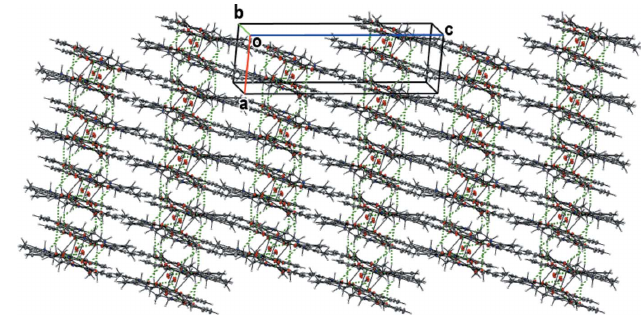
Figure 4 View of the two-dimensional sheets parallel to the ac